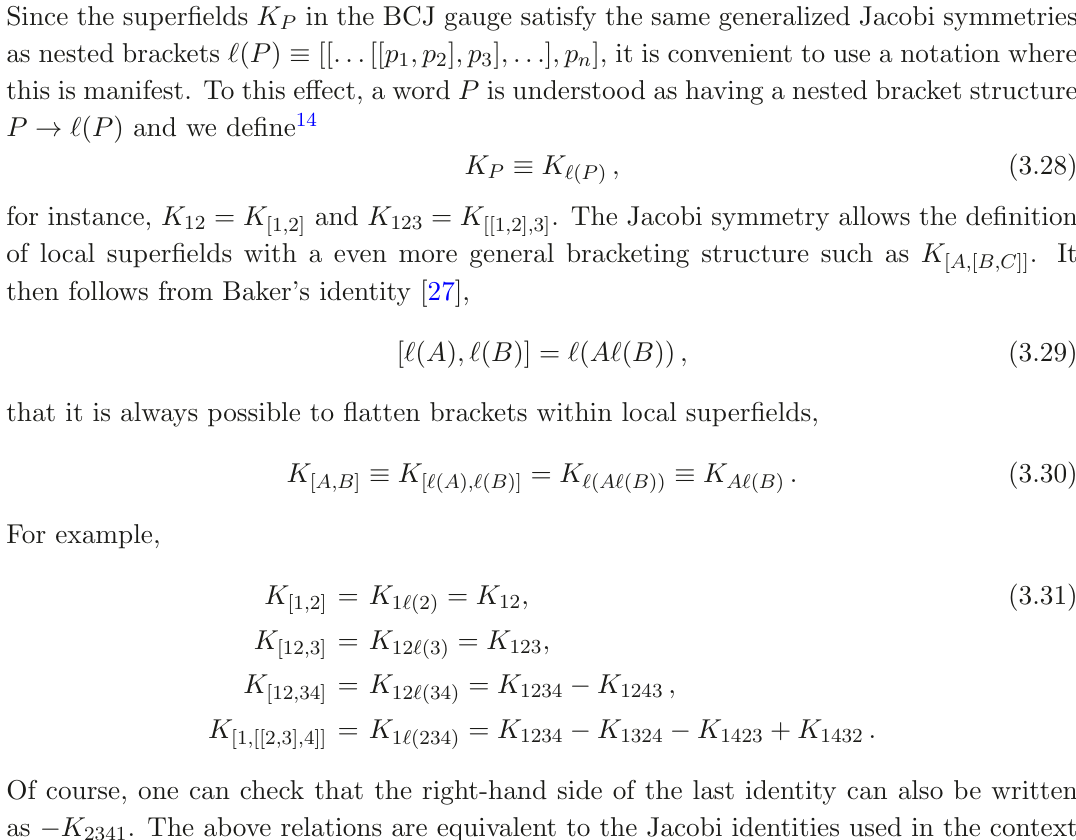
123 ...p = K P and tree-level